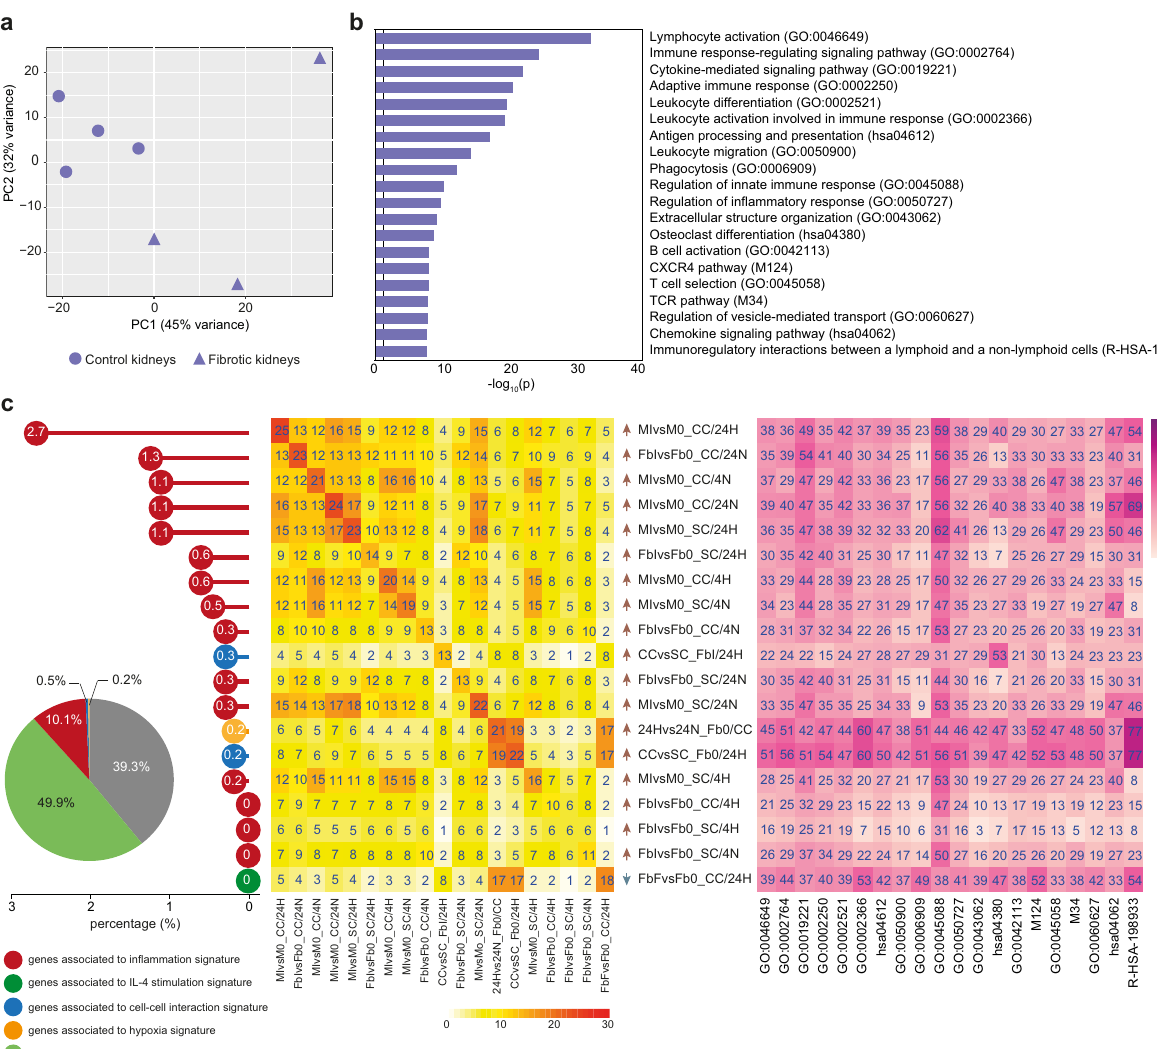
axis19in vitrosignatures enriched in ex vivo modeland their relative contribution with unique expressed genes: white numbers in each dot represent relative per- centagesonthetotalityofexplainedandnotexplainedgenes.Thecentralheatmap highlights the overlapping percentage of the same 19 in vitro signatures on the exvivosignature.Onthediagonal,numbersindicatetheoverlappingpercentageof each signature; the other numbers explain the overlapping percentage shared between two in vitro and the ex vivo signatures. Color intensity indicates the overlapping percentage level referred to ex vivo signature. Arrows near each in vitro signature indicate the positive (red) or negative (blue) enrichment of the fi rsttermofinvitrocomparison(seealsoFig.S8).Theheatmapontherightreports Metascape pathways in ex vivo comparison ( b ) with the percentage of enrichment given by each in vitro signature (on the